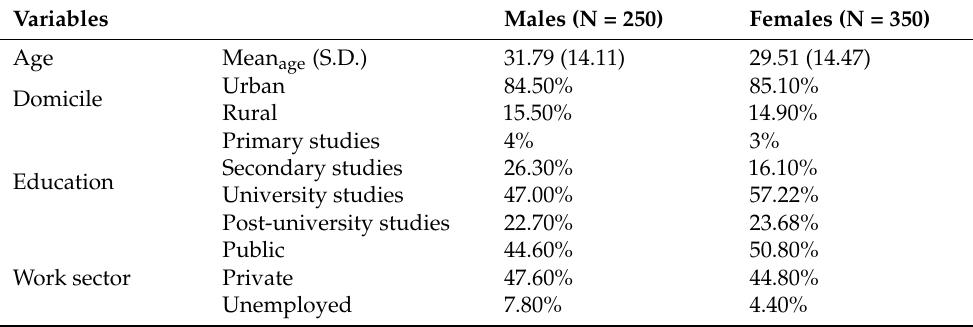
Table 1. The socio-demographic characteristics of the